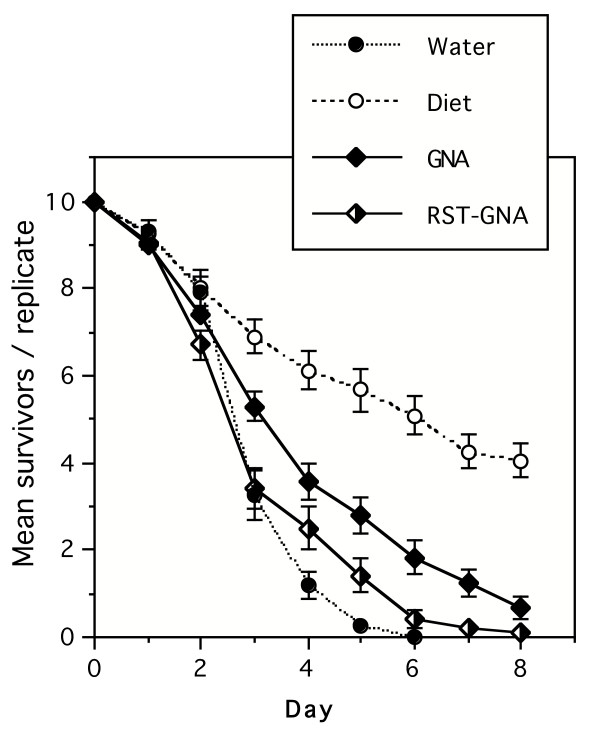
Effects of purified recombinant proteins on survival of rice brown planthopper. Third instar juveniles of N. lugens were fed on water only (mortality control), liquid artificial diet (negative control) and diet containing recombinant proteins at 0.5 mg/ml (= 0.05% w/v). Graph shows mean survival per replicate of 10 insects (± SE, n = 10 for water, diet, ButaIT/GNA, n = 20 for GNA).